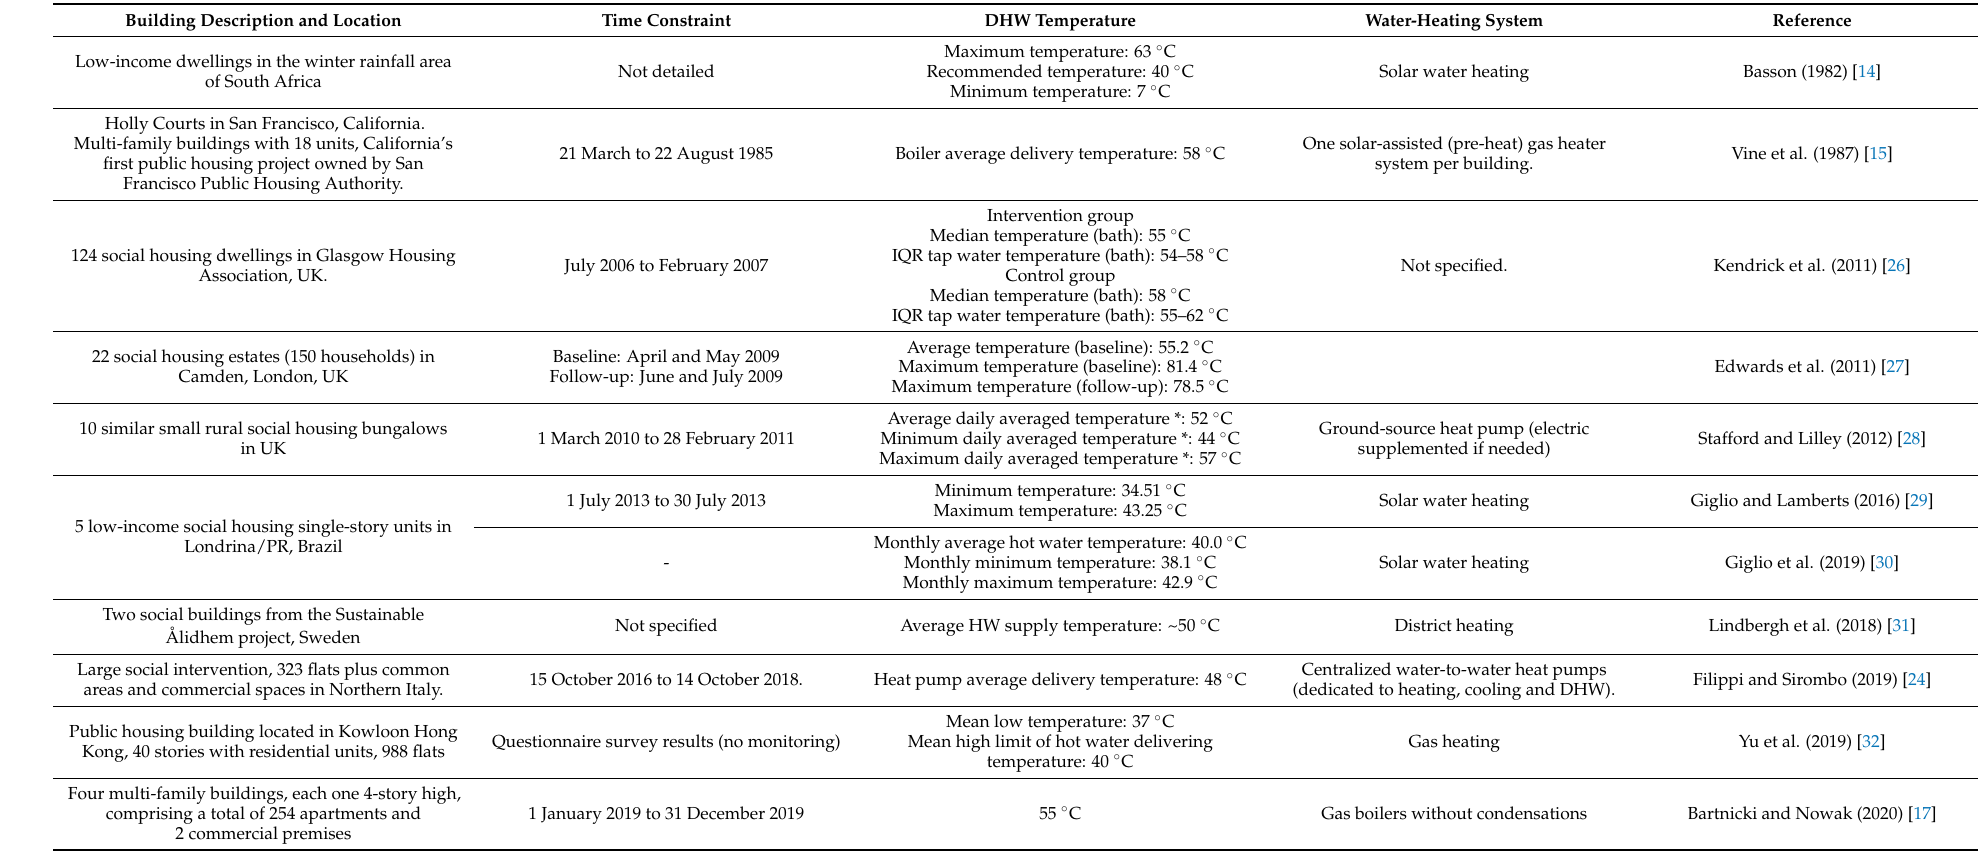
Table 3. Hot water temperature data from monitoring studies in social